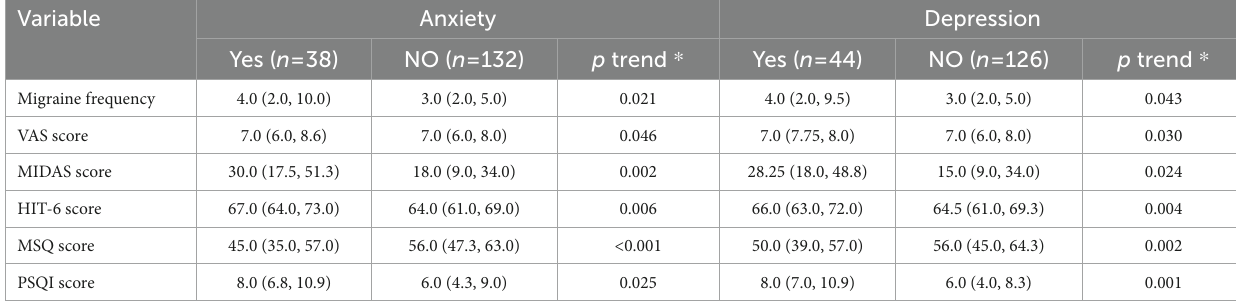
TABLE 4 Multivariate linear regression analysis of the effects of anxiety and depression on migraine-related burden. Variable